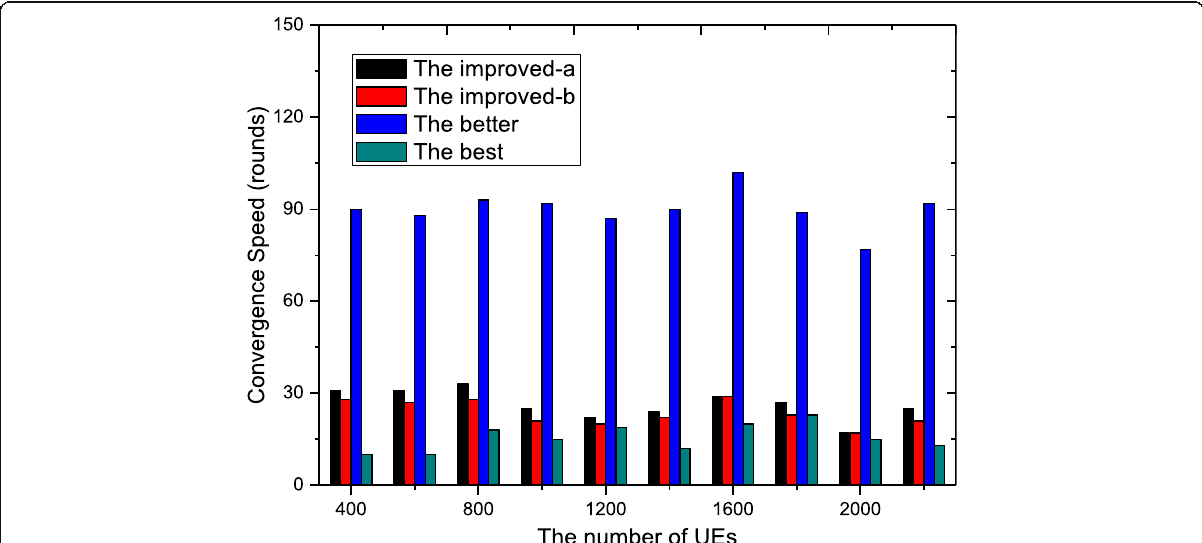
Fig. 13 Convergence performance comparison: variation trend of convergence time of TOM-PAOD with the number of UEs in the given region, in which the different game decision algorithms are adopted respectively